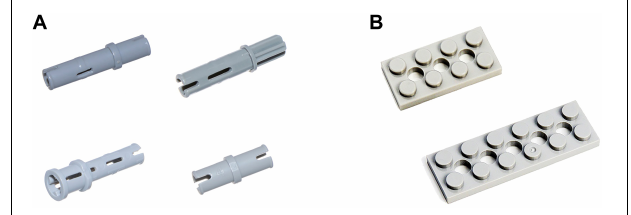
FIGURE 6 | Assembly tasks of different complexities. (A) High-complexity task with four alternative parts. (B) Low-complexity task with two alternative parts.